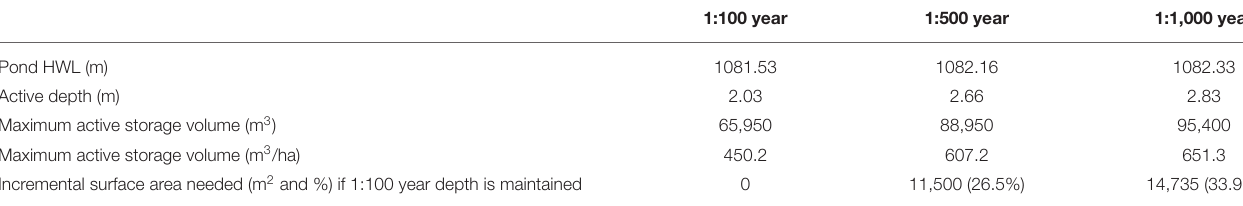
TABLE 4 | Storm pond performance − 24h duration